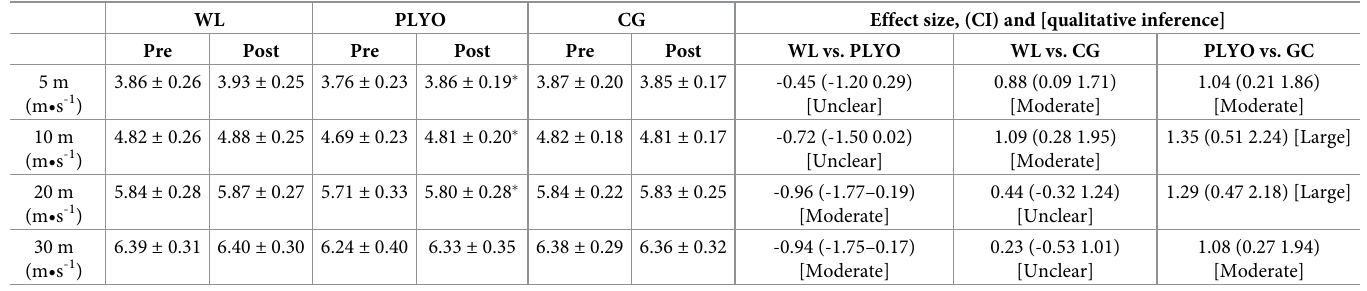
Values pre- and post-training are presented as mean ± standard deviation. CI = 95% confidence interval, 5 m = sprinting speed at 0–5 m, 10 m = sprinting speed at 0–10 m, 20 m = sprinting speed at 0–20 m, 30 m = sprinting speed at 0–30 m. � Significant difference from pre-training (p �